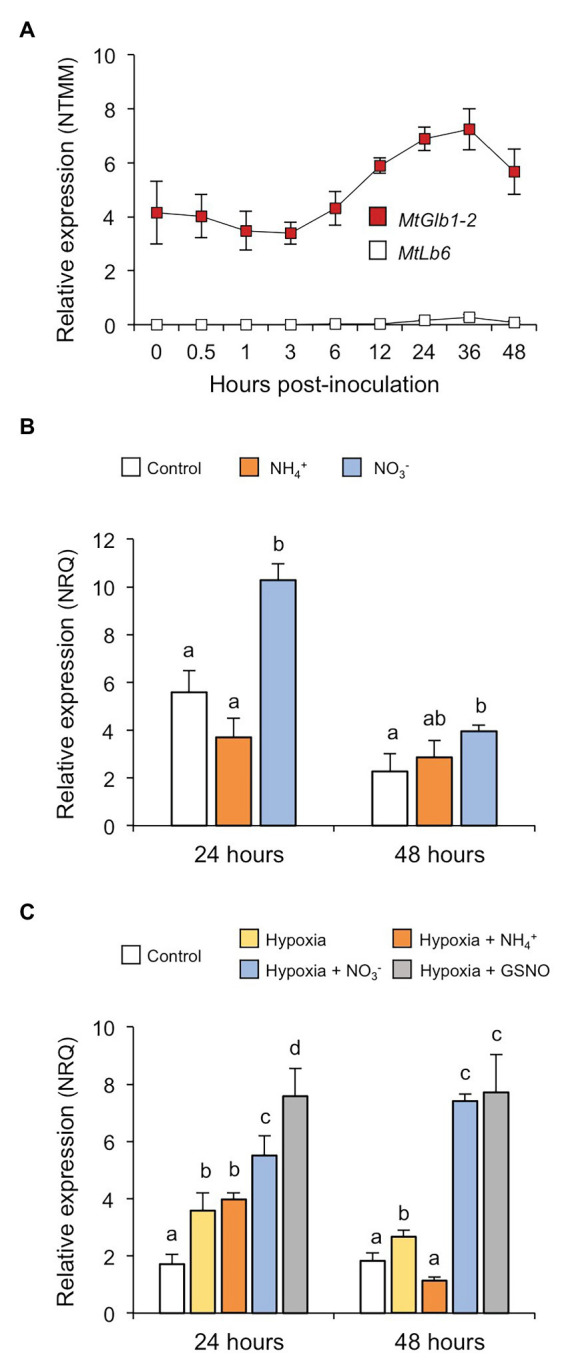
MtGlb1-2 expression is induced by hypoxia and NO. (A) Expression profile of MtGlb1-2 in roots after inoculation with Sinorhizobium medicae ABS7 (Larrainzar et al., 2015), now remapped to the latest Medicago truncatula genome version (Mt5.0). For comparison, the expression profile of a typical Lb gene (MtLb6) was included. Values are means with standard errors of four biological replicates for each time point. (B) Effect of NH4+ and NO3− on MtGlb1-2 expression in roots. Plants were grown for 11 days on Fahräeus plates and then transferred to fresh plates unsupplemented (controls) or supplemented with 2 mM NH4Cl or 2 mM KNO3. (C) Effect of hypoxia in the absence and presence of NH4+, NO3−, or S-nitrosoglutathione (GSNO) on MtGlb1-2 expression in roots. Plants were grown for 11 days on Fahräeus plates and roots were submerged for 24 and 48 h in 5 mM phosphate buffer (pH 7.0) alone (hypoxia) or supplemented with 2 mM NH4Cl, 2 mM KNO3, or 2 mM GSNO. Controls were run in parallel by growing plants for 13 days on plates. Transcript levels were determined by qRT-PCR and expressed as normalized relative quantities (NRQs). Data are means of 3–5 biological replicates with standard errors. Statistical analyses were performed using log2(NRQ)-transformed data (Rubio et al., 2019) and comprised one-factor analysis of variance and one-tailed Student’s t-tests for mean comparisons. Means denoted by the same letter do not differ at p < 0.05.